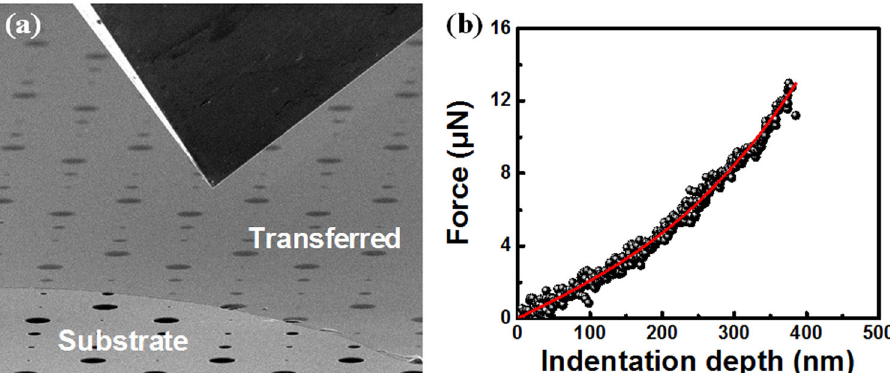
Fig. 11 In-situ SEM nano-indentation on Super Yellow fl ake: a SEM image before nano-indentation and b typical force-penetration depth curve